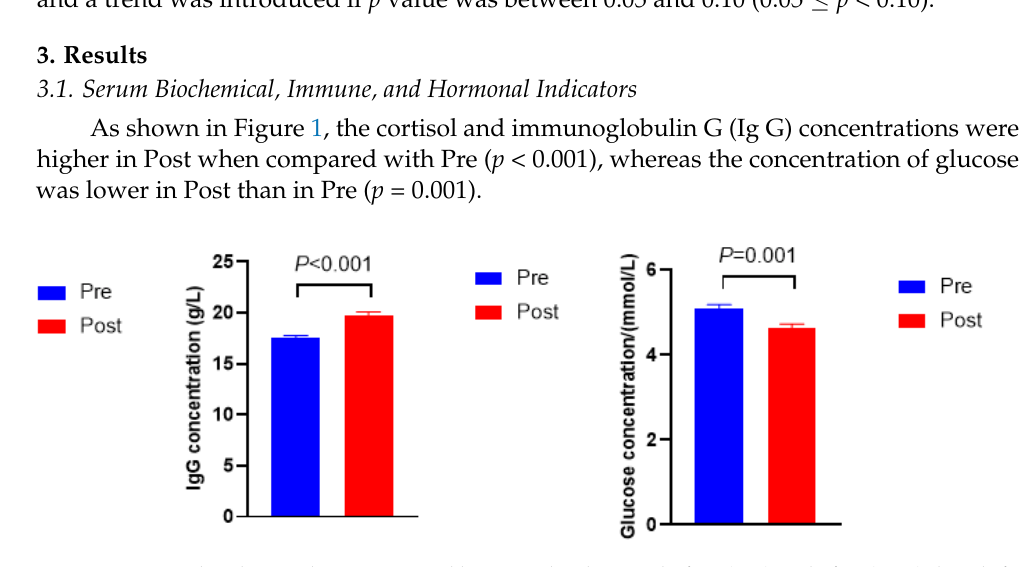
Figure 1. Serum biochemical, immune, and hormonal indicators before (Pre) and after (Post) diet shift.